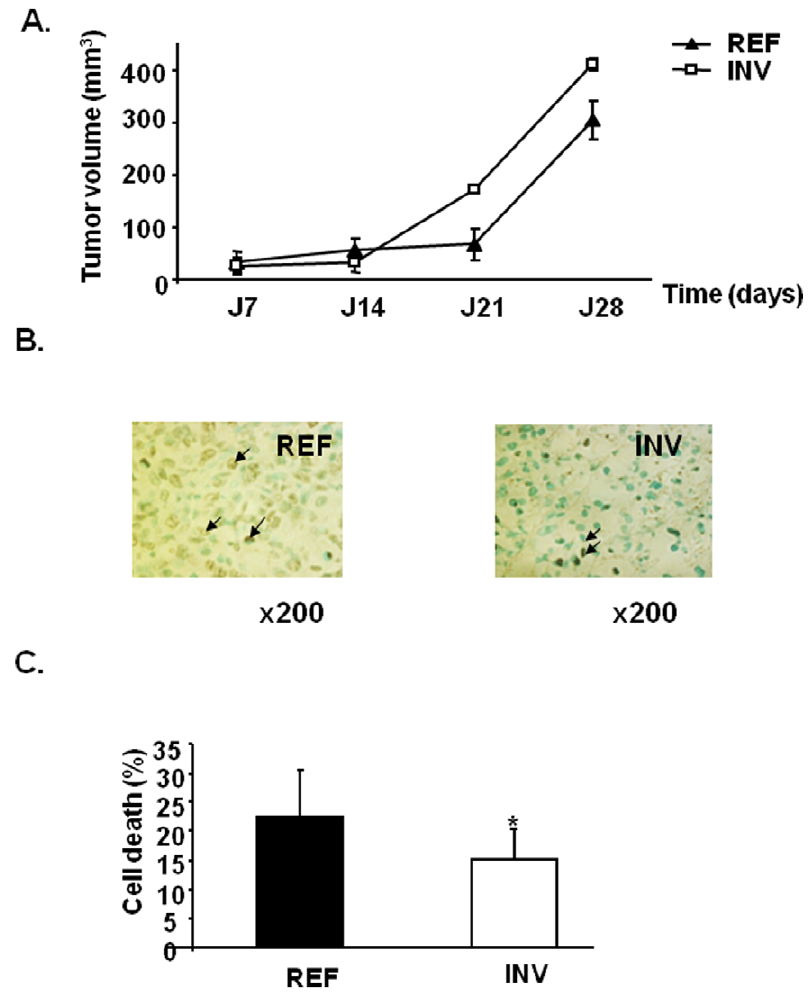
Figure 4. REF and INV tumor growth. INV and REF cells were injected subcutaneously near mammary gland into nude mice as described in ‘‘Materials and Methods’’. After 1 week, tumors appeared in each group (A). Each point represents the mean tumor volume (mm 3 ) ( 6 SD, n=7). Dead cells in REF and INV tumor sections were stained (B). Arrows indicate apoptotic and necrotic cells (magnification 6 200). Percentage of cell death was determined as described in ‘‘Materials and Methods’’